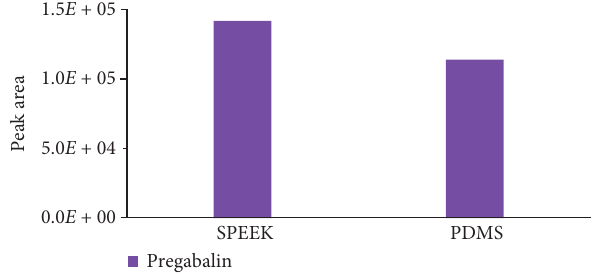
Figure 3: Comparison of SPEEK and PDMS as a sorbent. Ex- tractions were performed at identical conditions.